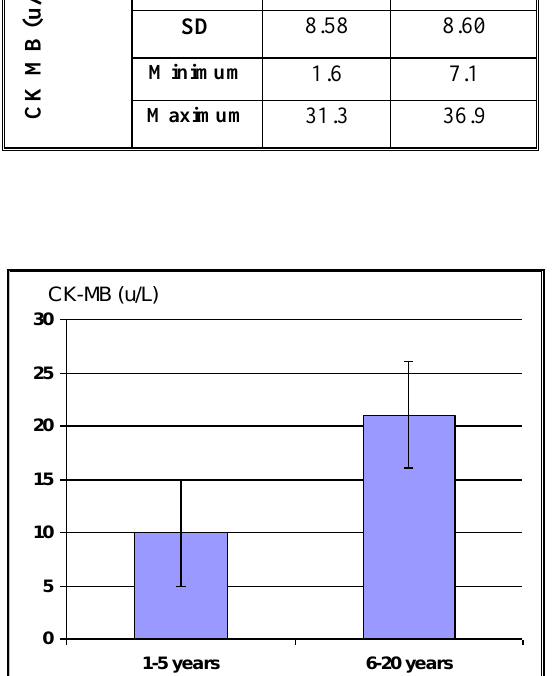
Figure(1) : Correlation between time of atenolol usage and serum